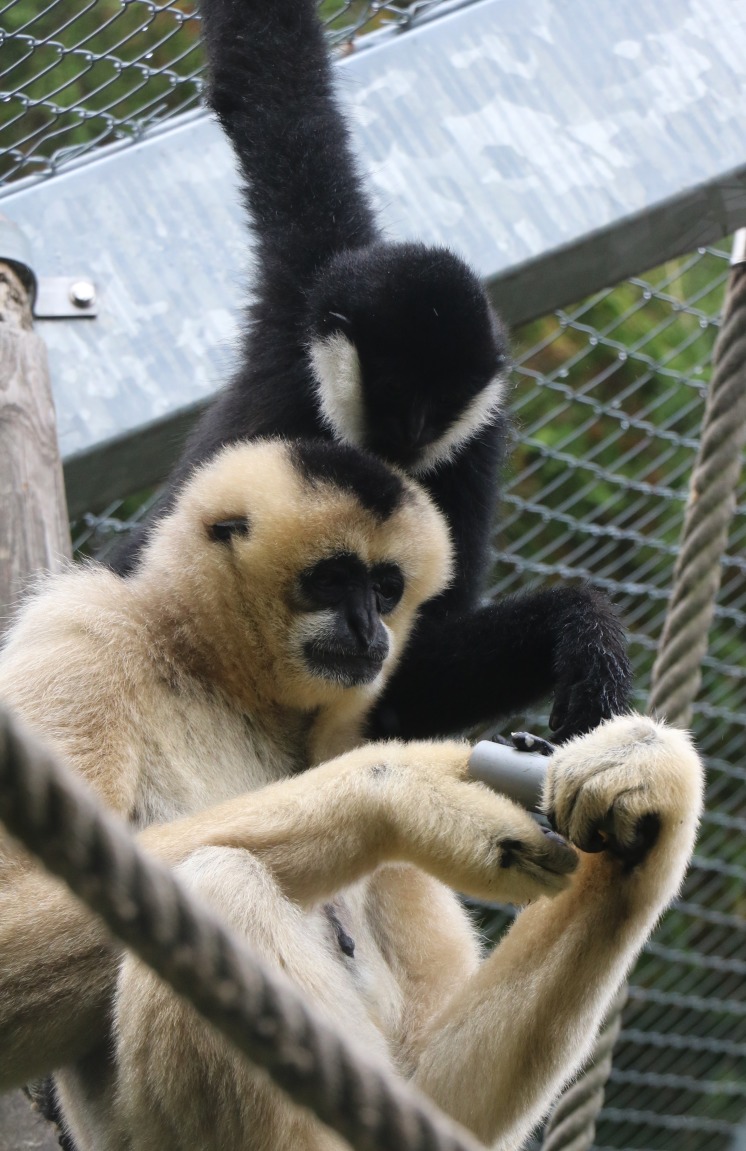
Adult female N. leucogenys. engages in the tube task, observed by an infant.Photo credit: Miriam Lindenmeier.